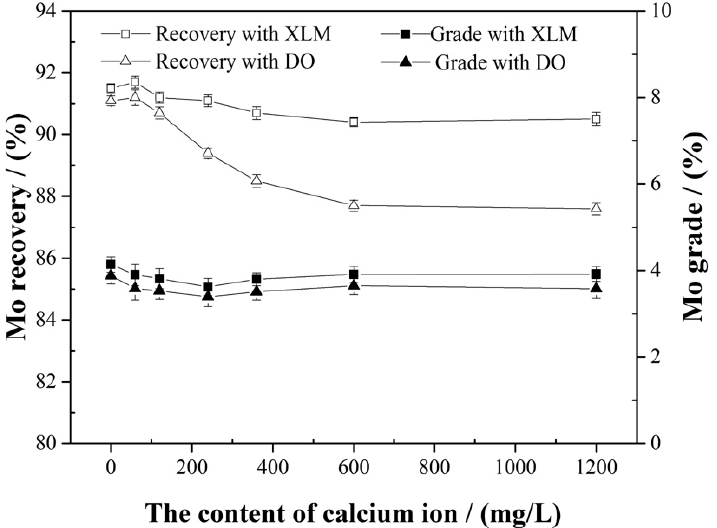
Figure 5. Comparison study between XLM and DO as the collector as a function of Ca 2+ concentration at pH = 8.